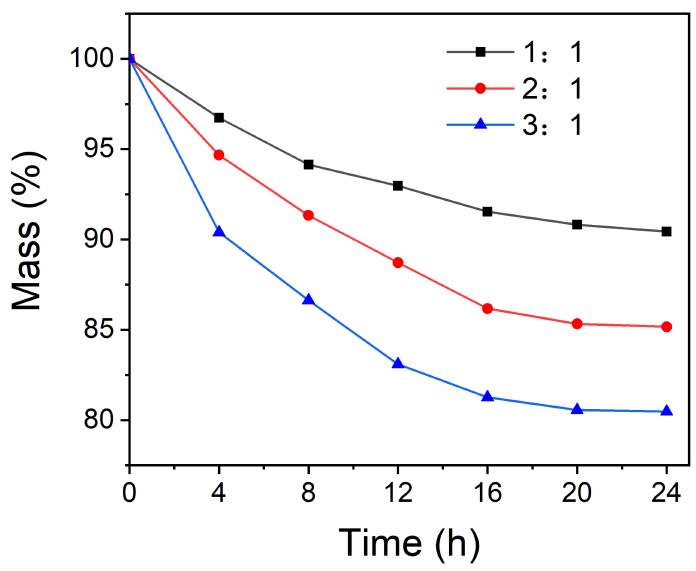
Figure 8. The mass loss of the microcapsules with core/shell ratio of 1:1, 2:1 and 3:1 at 80 ◦